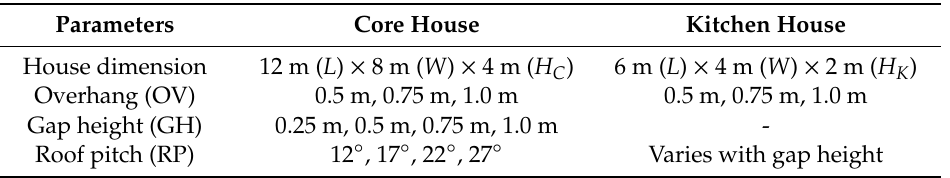
Table 1. Parameters of the rural house.